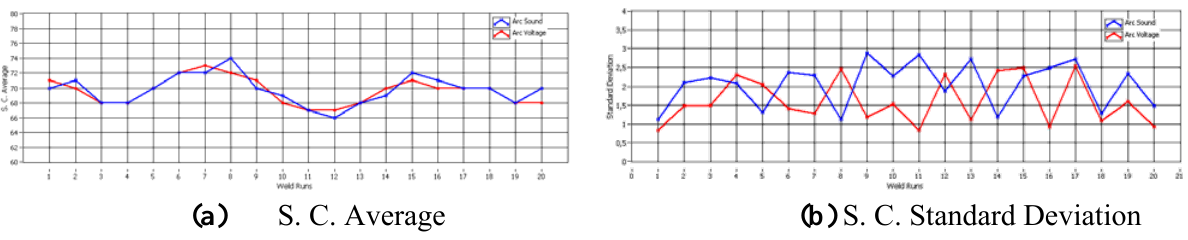
Figure 11. Short circuits average and standard